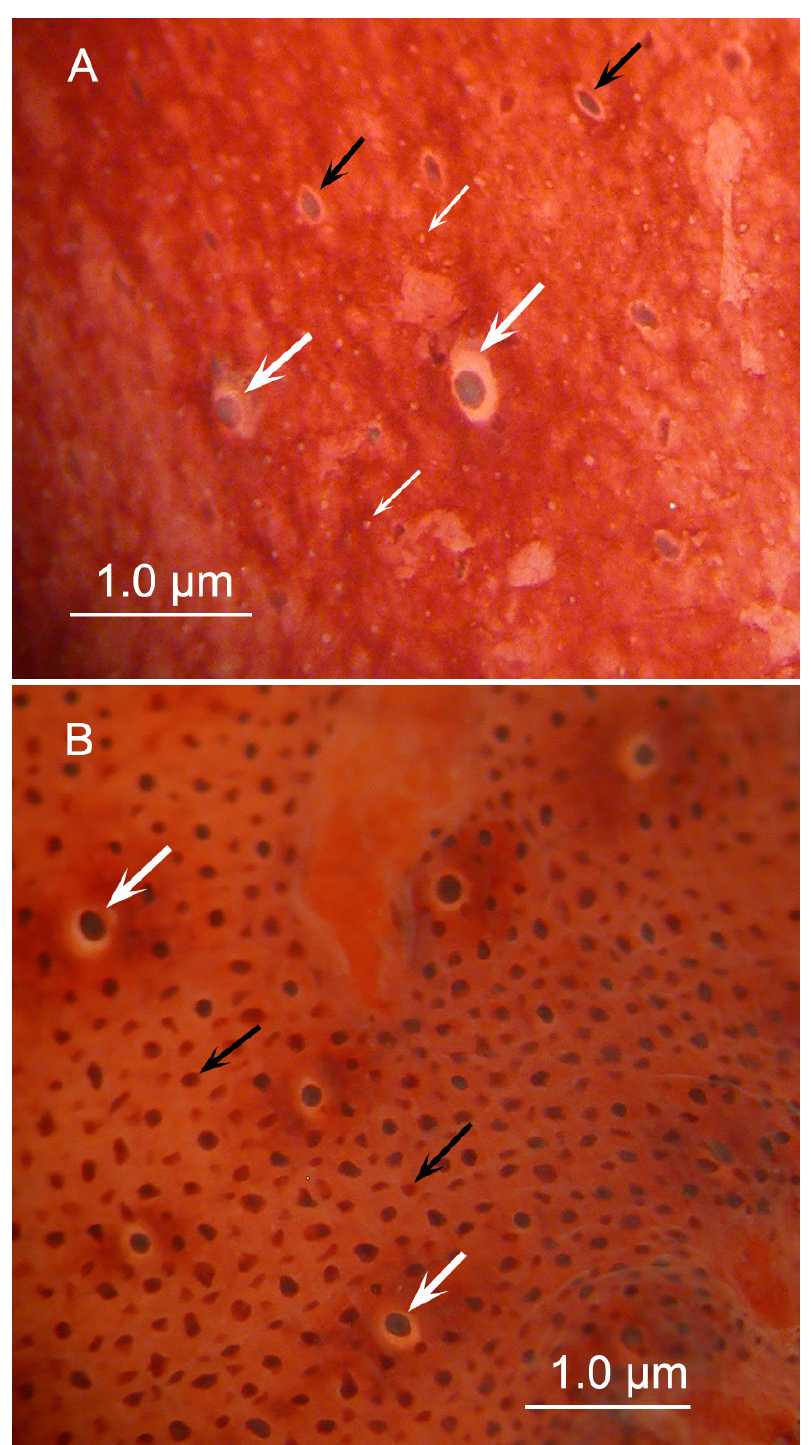
Fig. 2. Photomicrographs of the slightly damaged integument of the head (modified from Vecchione et al . 2004–2014). A . Mastigoteuthis agassizii . B . “ Mastigoteuthis ” pyrodes [= Mastigotragus pyrodes ]. – Large, white arrows indicate photophores; only two photophores are visible in A but seven are visible in B. Small, white arrows indicate two of the many “white spherical structures.” Black arrows indicate ringed chromatophores in A and typical chromatophores in